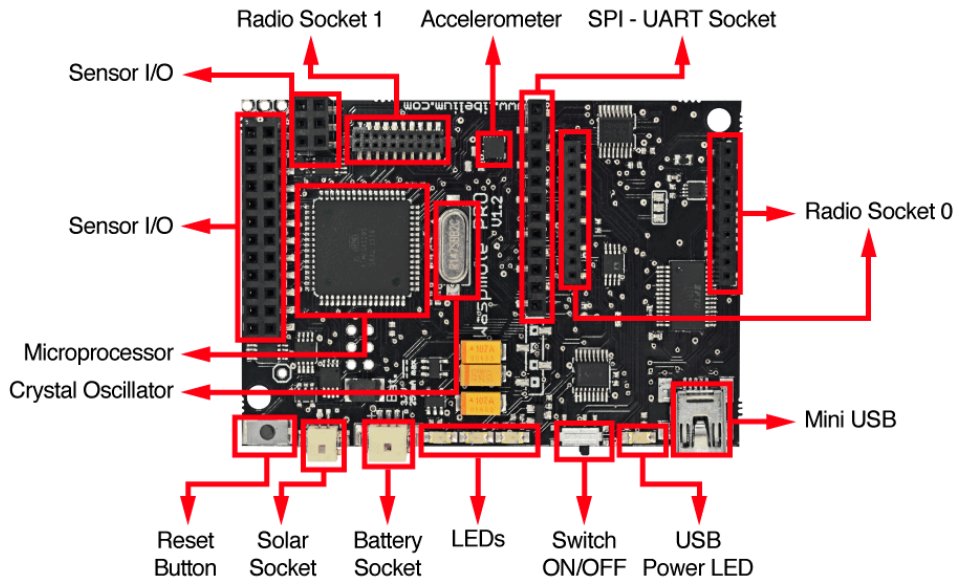
Figure 3. Waspmote Sensor Node.